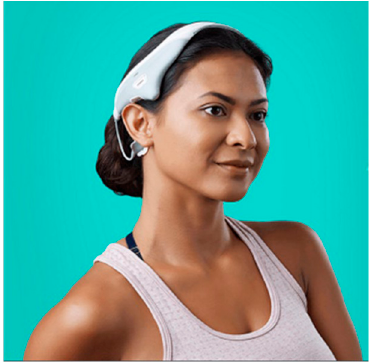
Figure 2. Modius Stress device (Image sourced from NEUROVALENS).